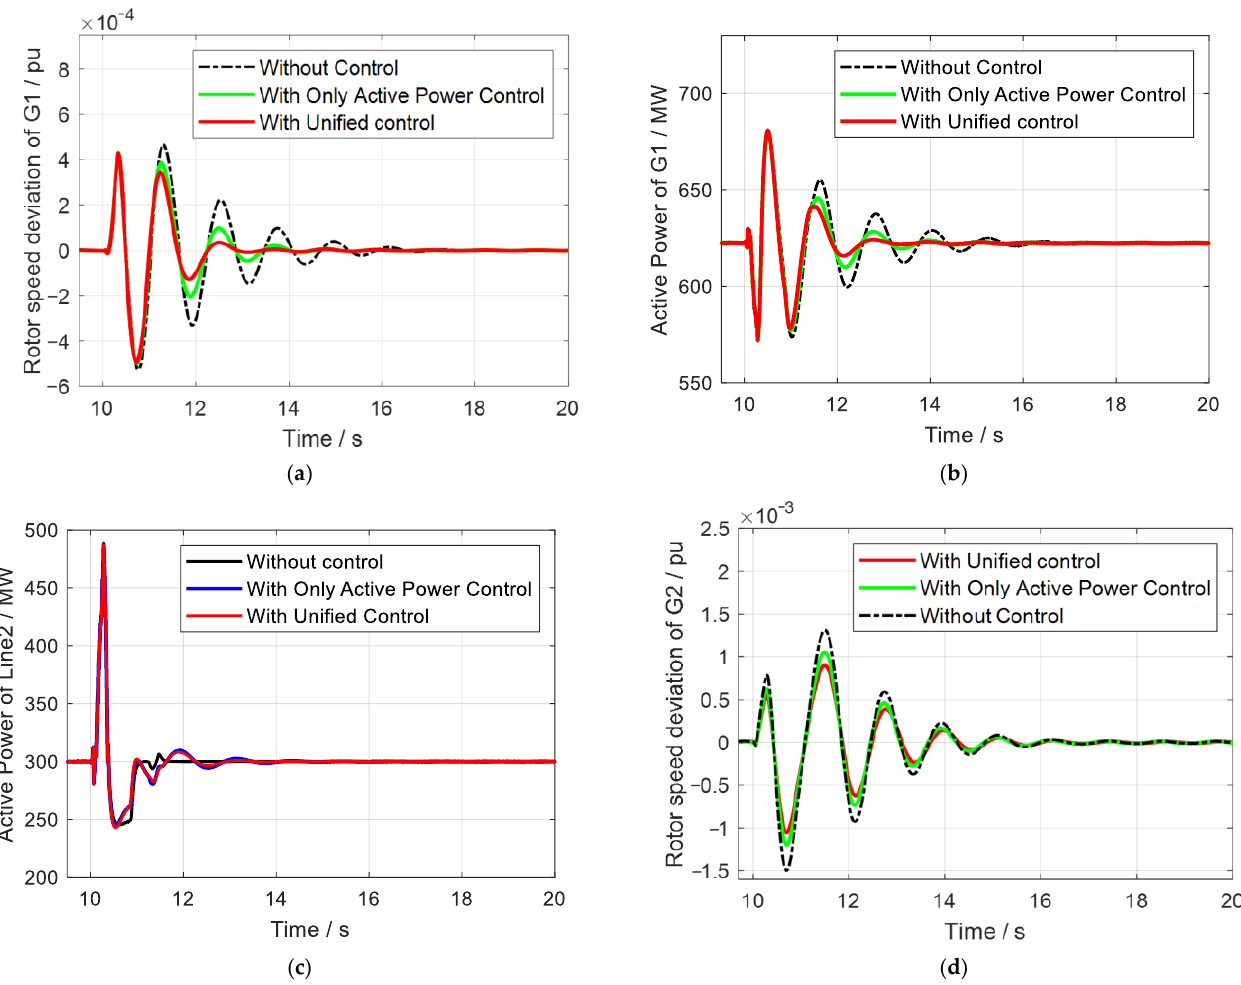
Figure 13. Simulation situations in case2. ( a ) The rotor speeds deviation of plant 1 with and without control in different situations. ( b ) The output active power of plant 1 with and without control in different situations. ( c ) The active power transmitted on Line 2 with and without control in different situations. ( d ) The rotor speeds deviation of plant 2 with and without control in different situations. Table 4. The Damping ratio changing situations with different controls.